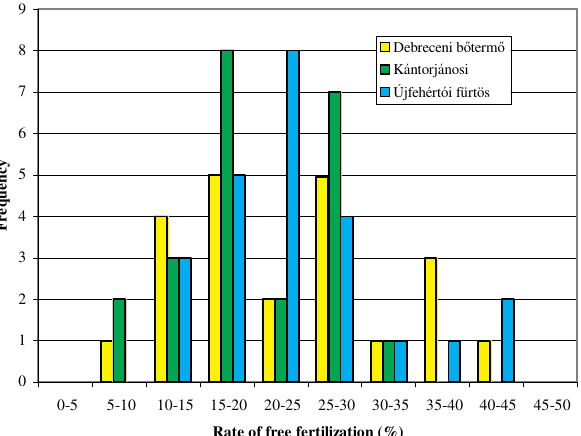
Figure 1: Distribution of free fertilization at reaserched sour cherry